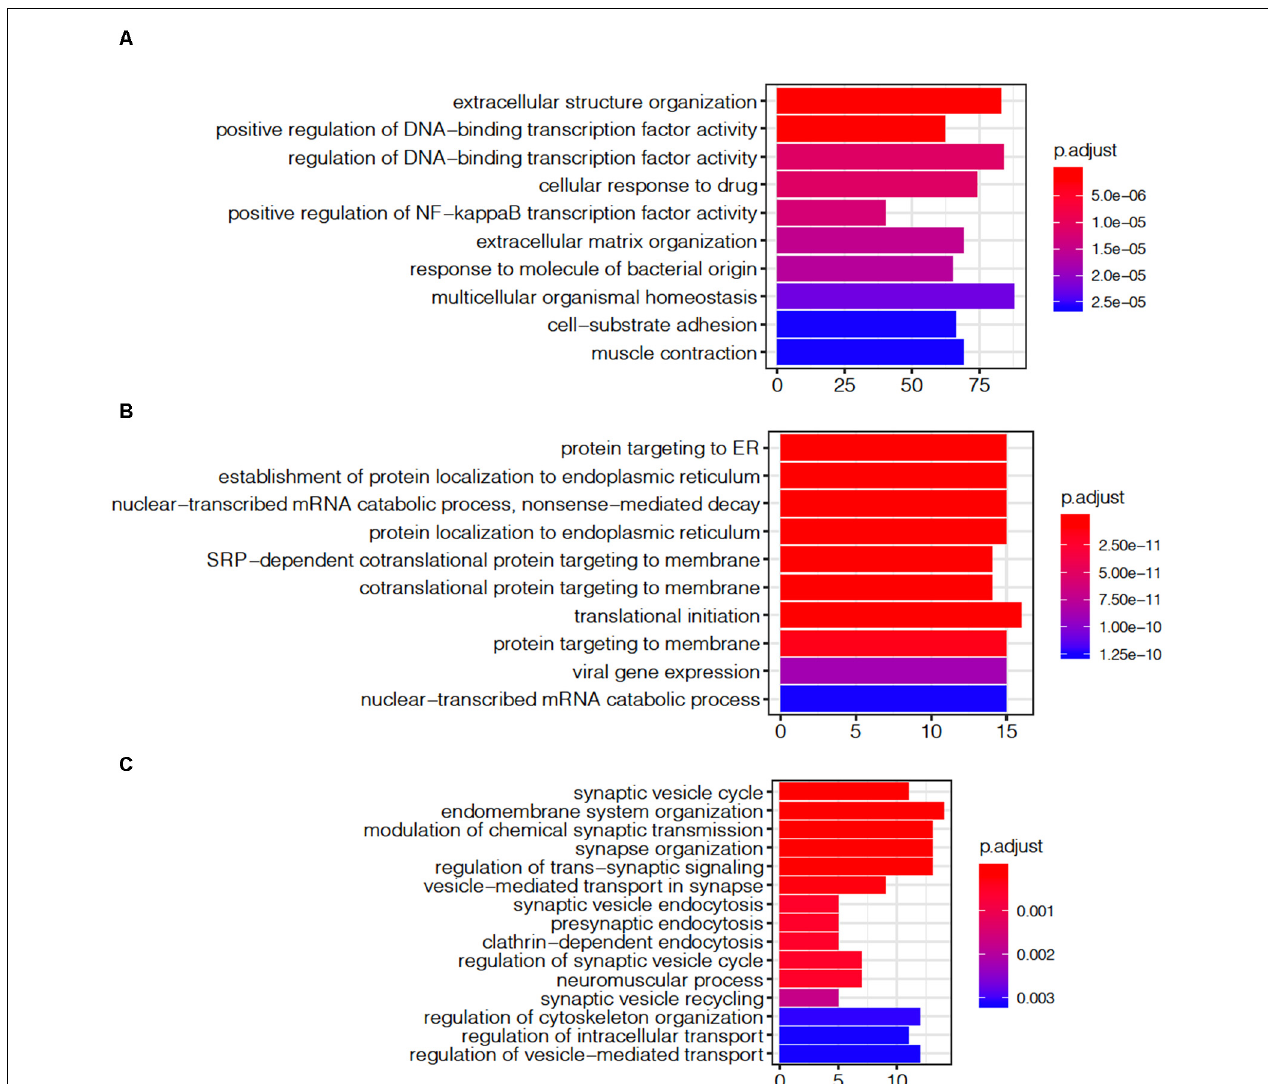
FIGURE 7 | Gene ontology enrichment analysis of agonal-related modules: (A) ME1; (B) ME12; and (C)